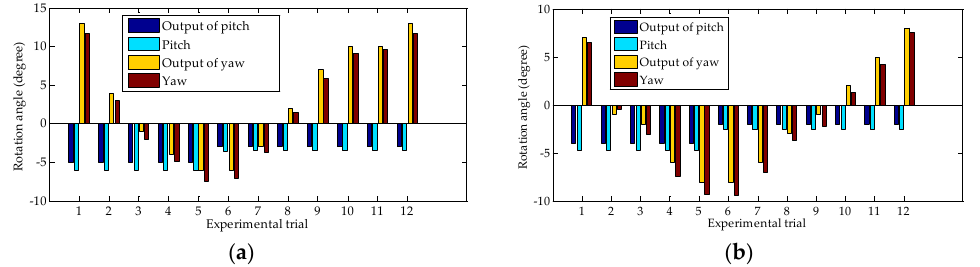
Figure 8. Our calculated rotation angles and the corresponding rough values: ( a ) Rotation angles of the left camera; ( b ) Rotation angles of the right camera.